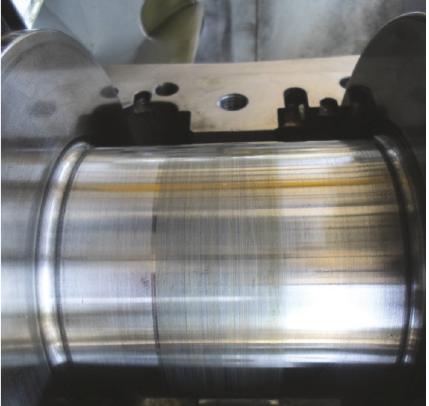
Figure 15: Compressor rotor inlet bearing shaft showing vibration